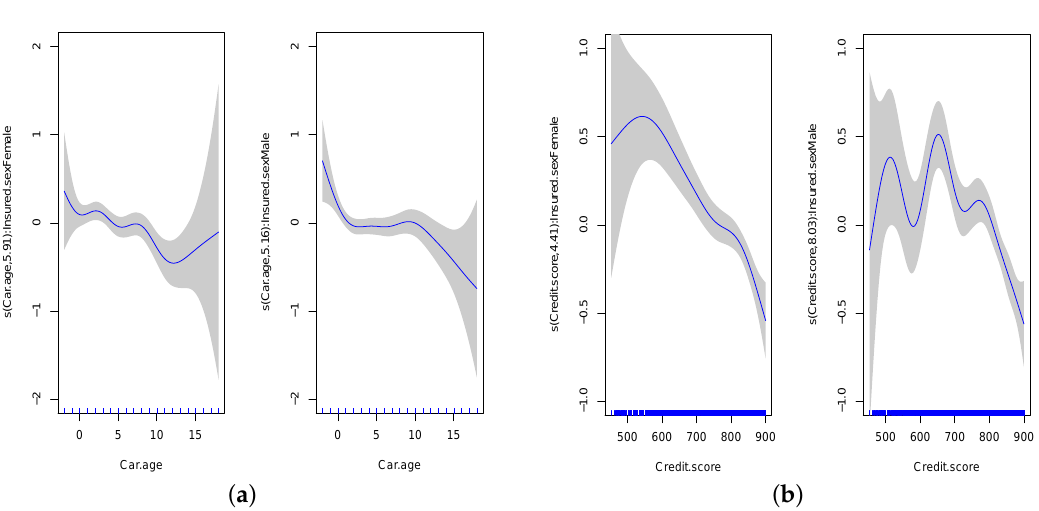
Figure 8. The plots of fitted spline functions for Car Age and Credit Scores, separated by Insured Sex. ( a ) Car Age by Insured Sex; ( b ) Credit Scores by Insured Sex.